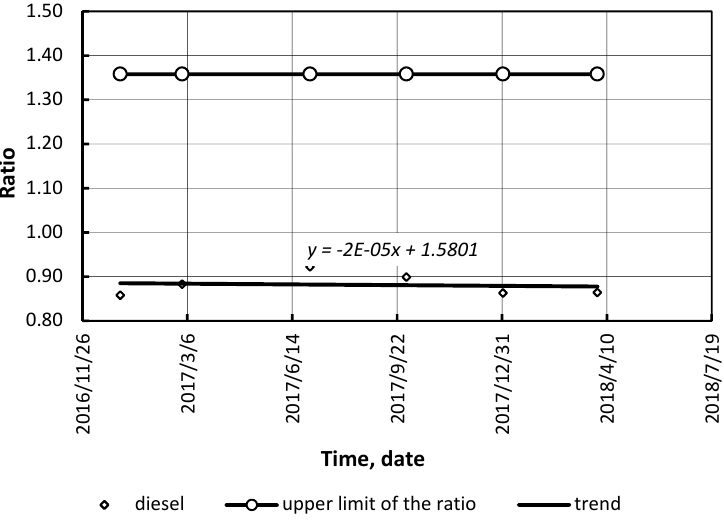
Figure 16. CNG / diesel prices ratio in Germany. Figure 16. CNG/diesel prices ratio in Germany. Figure 16. CNG/diesel prices ratio in Germany.